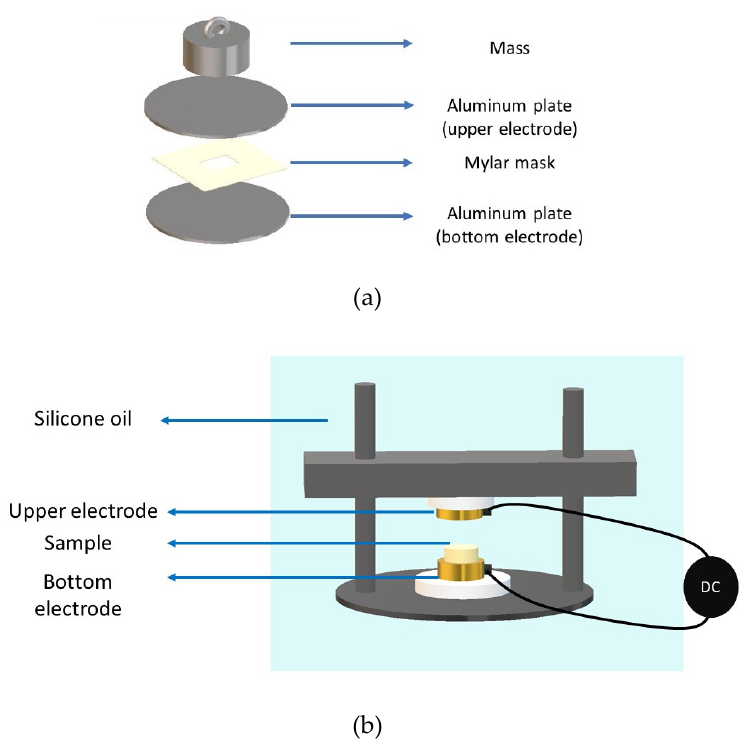
Figure 1. ( a ) Set up developed to produce the composites. ( b ) Poling set up.